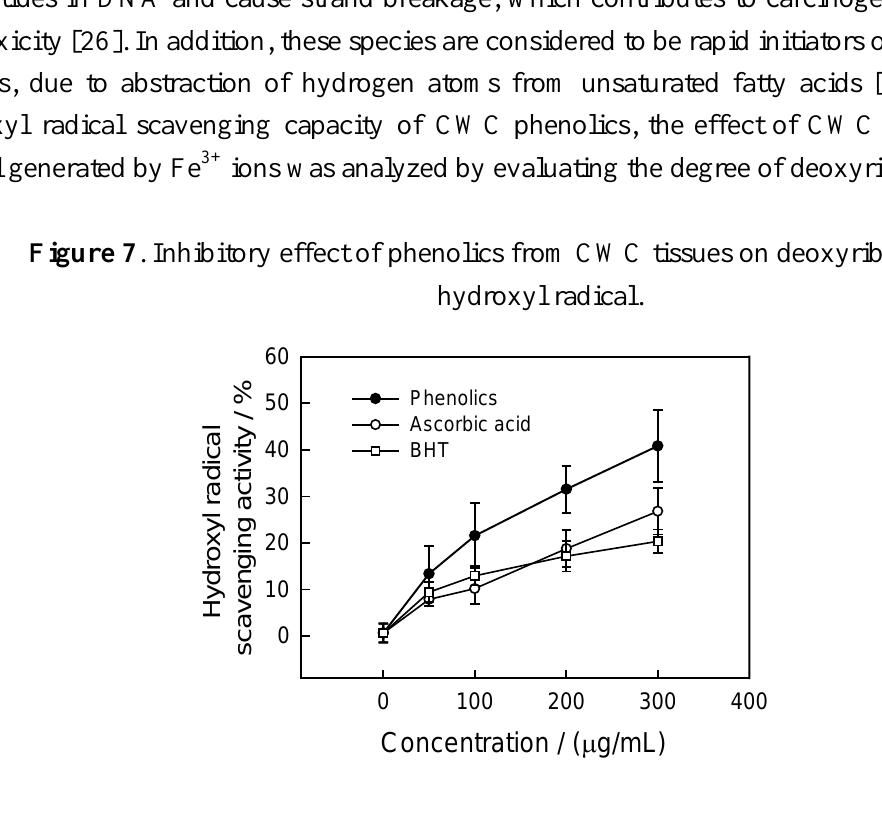
Concentration / ( µ